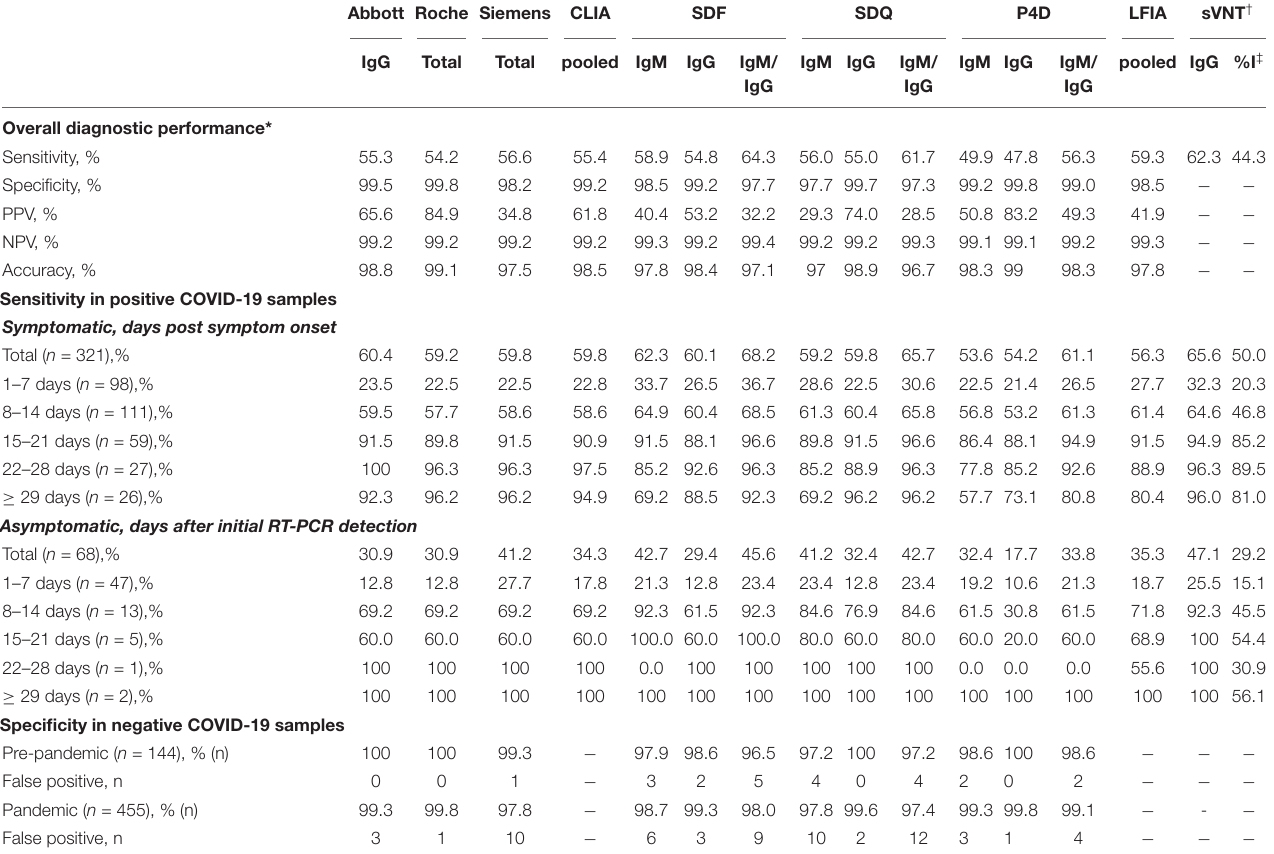
TABLE 3 | Diagnostic performance of SARS-CoV-2 antibody assays according to days after symptom onset. Abbott Roche Siemens CLIA SDF SDQ P4D